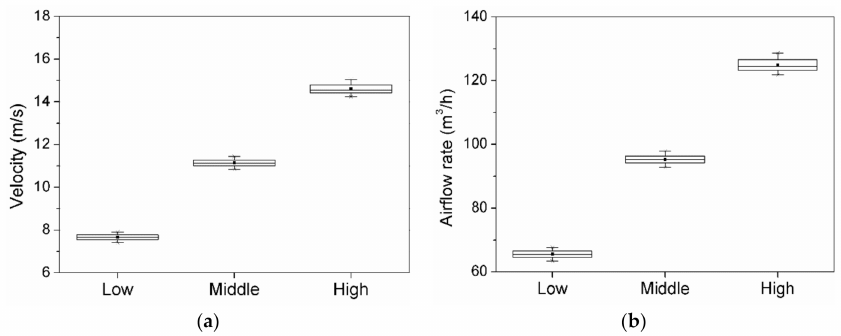
Figure 4. Box plot of the velocity and airflow rate: ( a ) velocity; ( b ) airflow rate.